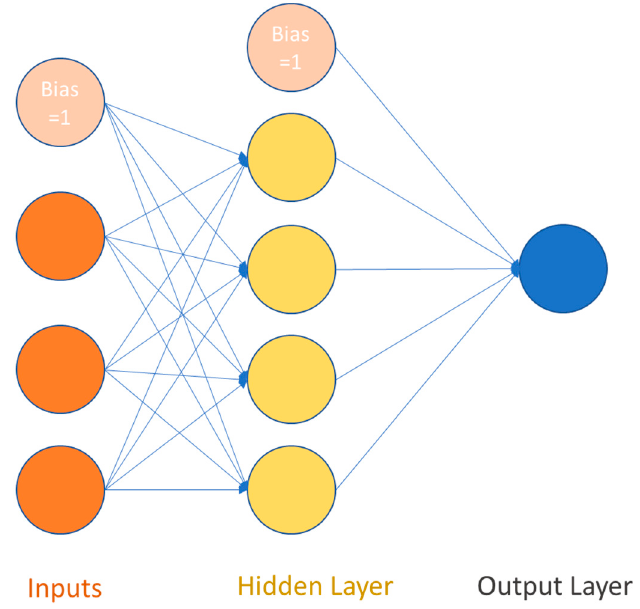
Figure 6. Forward propagation neural network [46] .